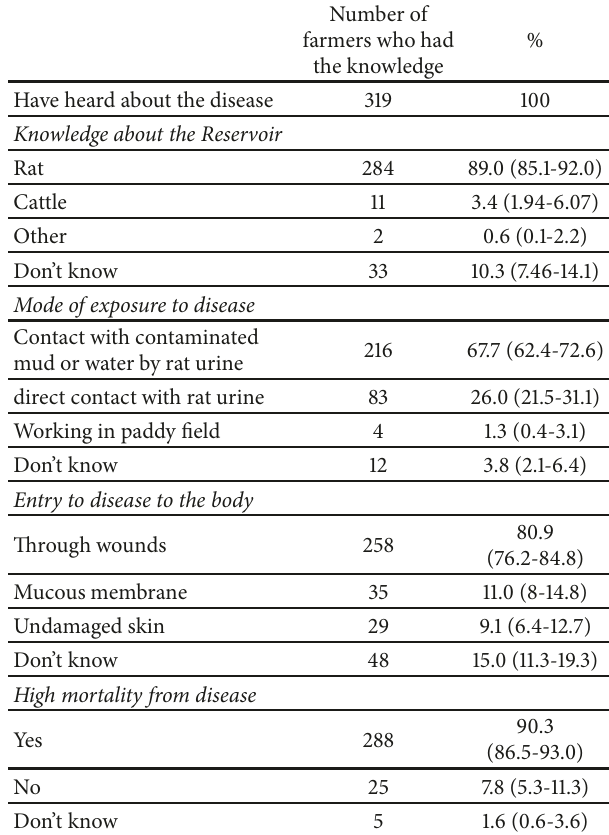
Table 3: Knowledge about the transmission of leptospirosis among